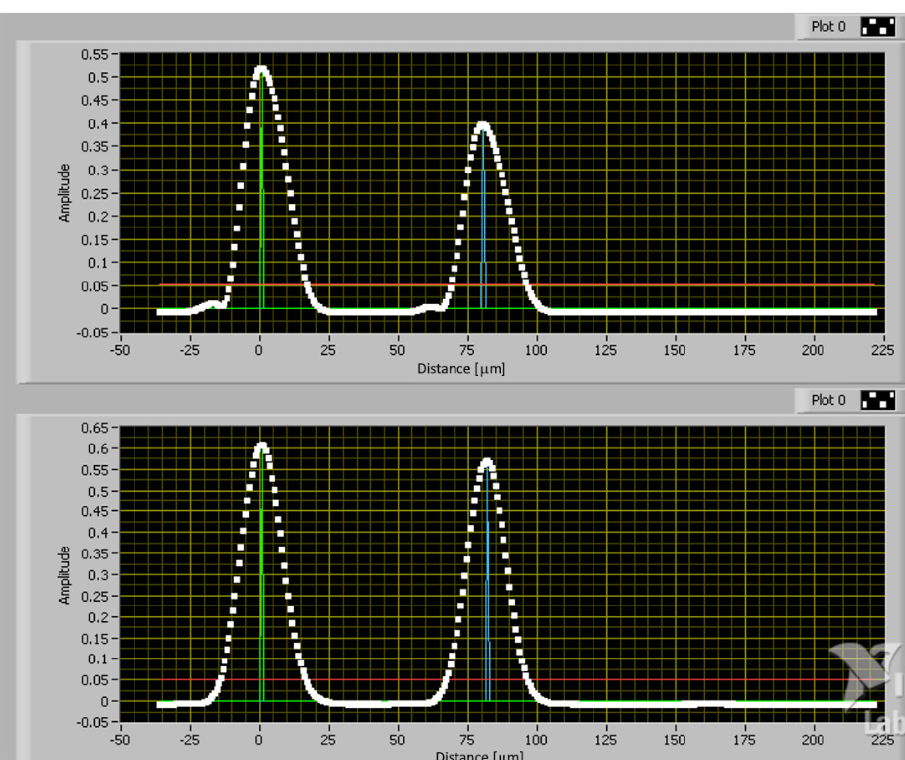
Figure 15. LabVIEW screenshot of the measurement acquired on a real bubble in a working plant, for a transparent film with thickness 80 μ m, during rise ( top ) and fall ( bottom ) of the triangular wave. Amplitude scale: 50 mV/division. Horizontal scale: 25 μ m/division. The two vertical lines indicate the position of the peaks, localized by the parabolic regression algorithm.